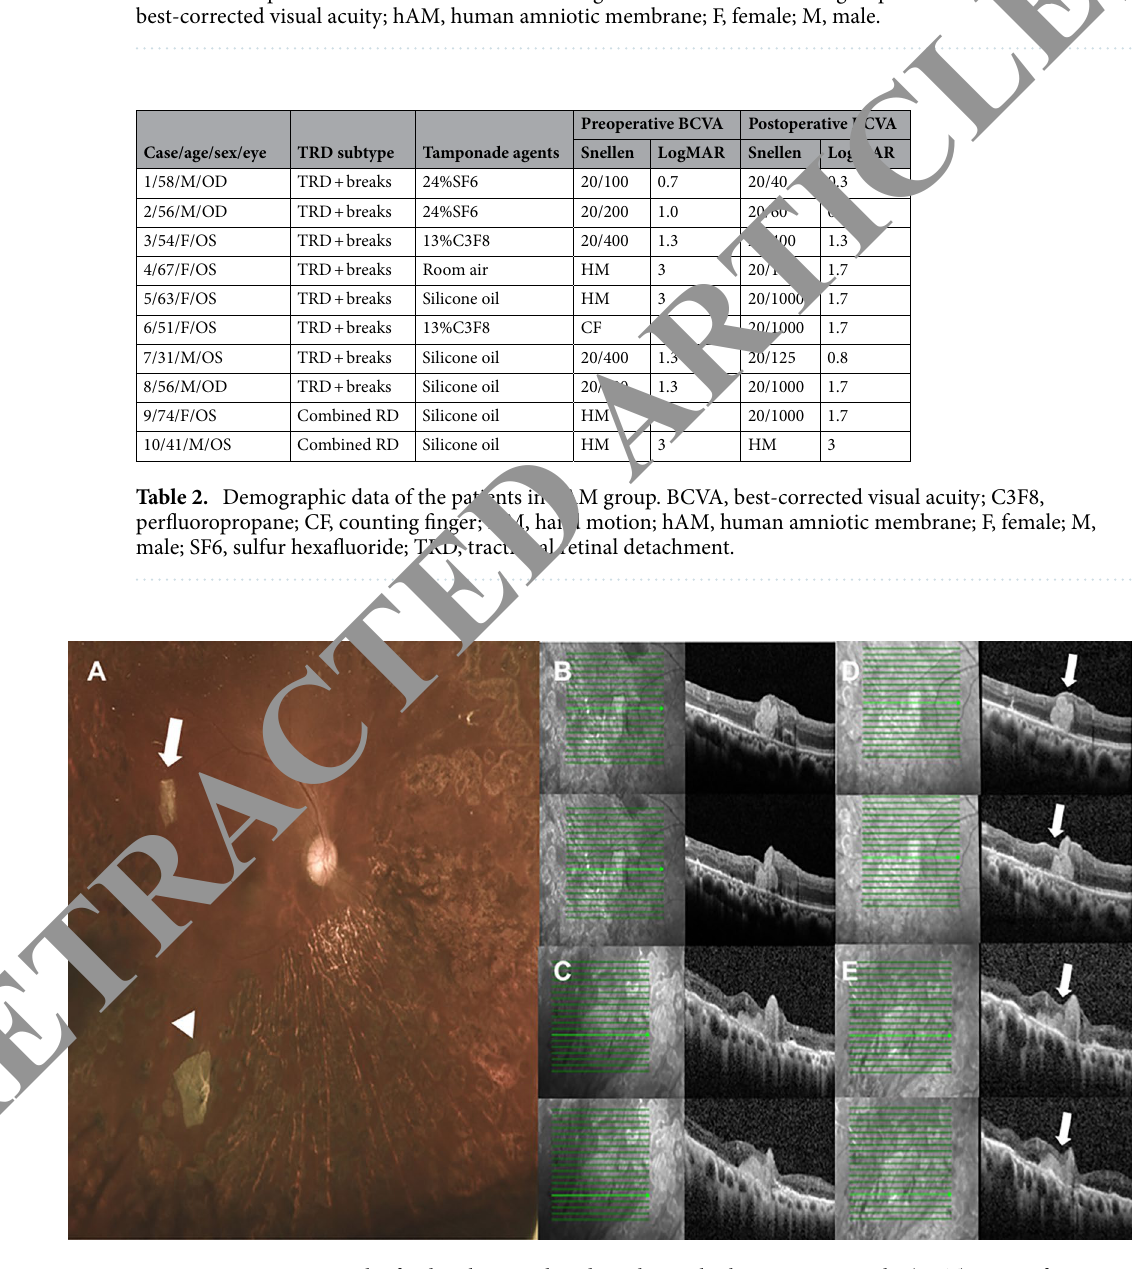
Figure 1. Postoperative color fundus photograph and serial optical coherence tomography (OCT) exams of case 1. ( A ) Color fundus photograph showed the two retinal breaks sealed securely by two human amniotic membrane (hAM) grafts (arrow and arrow head). ( B , C ) Two months after surgery, OCT scans over the location of superior temporal break (arrow) and inferior temporal break (arrow head) showed the retina breaks well sealed by the grafts. ( D , E ) One year later, OCT scan over the same location showed that the grafts stayed in place without graft dislocation or lysis. Besides, some retina and glial tissue regeneration were observed at the retina break